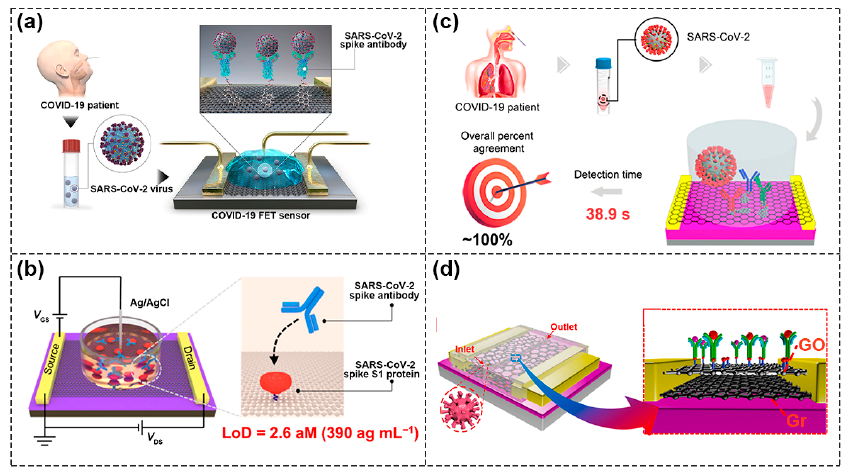
Figure 9. COVID − 19 detection based on different FET biosensors. ( a ) Schematic of the SARS − CoV − 2 Figure 9. COVID–19 detection based on different FET biosensors. ( a ) Schematic of the SARS–CoV–2 spike antibody coupled to graphene sheet for detecting SARS − CoV − 2 virus. Reproduced with spike antibody coupled to graphene sheet for detecting SARS–CoV–2 virus. Reproduced with